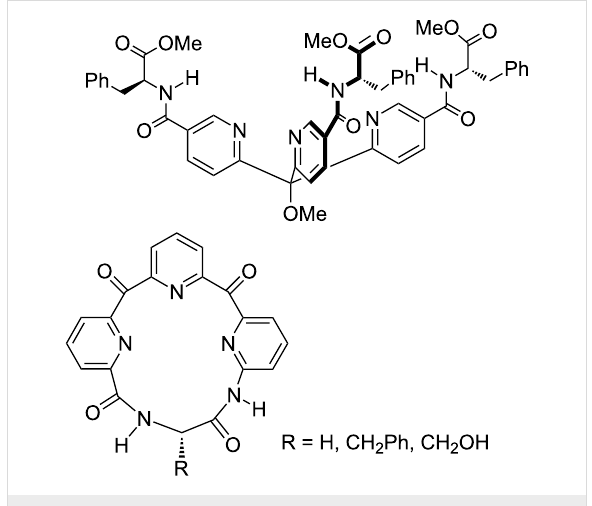
Figure 4: Tris-pyridyl